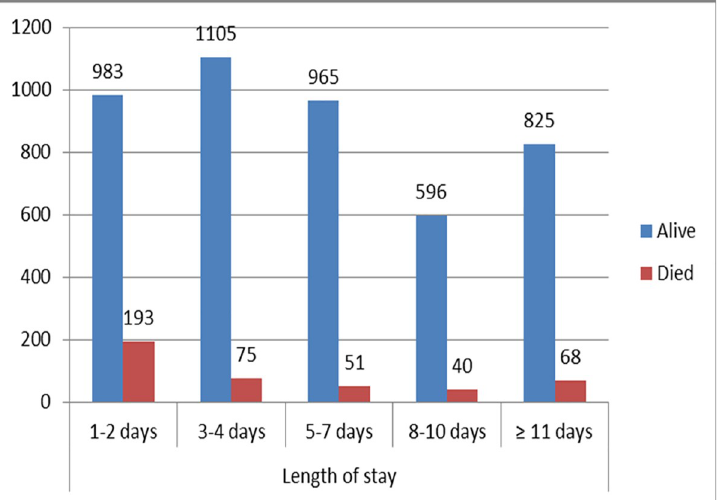
Fig 1. Discharge condition of children along with the length of stay in Asella Teaching & Referral Hospital, 2020.